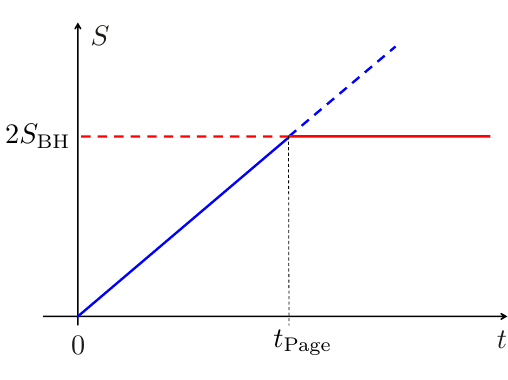
Figure 2 . The Page curve for the eternal Schwarzschild black hole. In this plot we ignore terms of higher order in c G N =r D (cid:0) 2 , which are small compared to t Page or S BH h